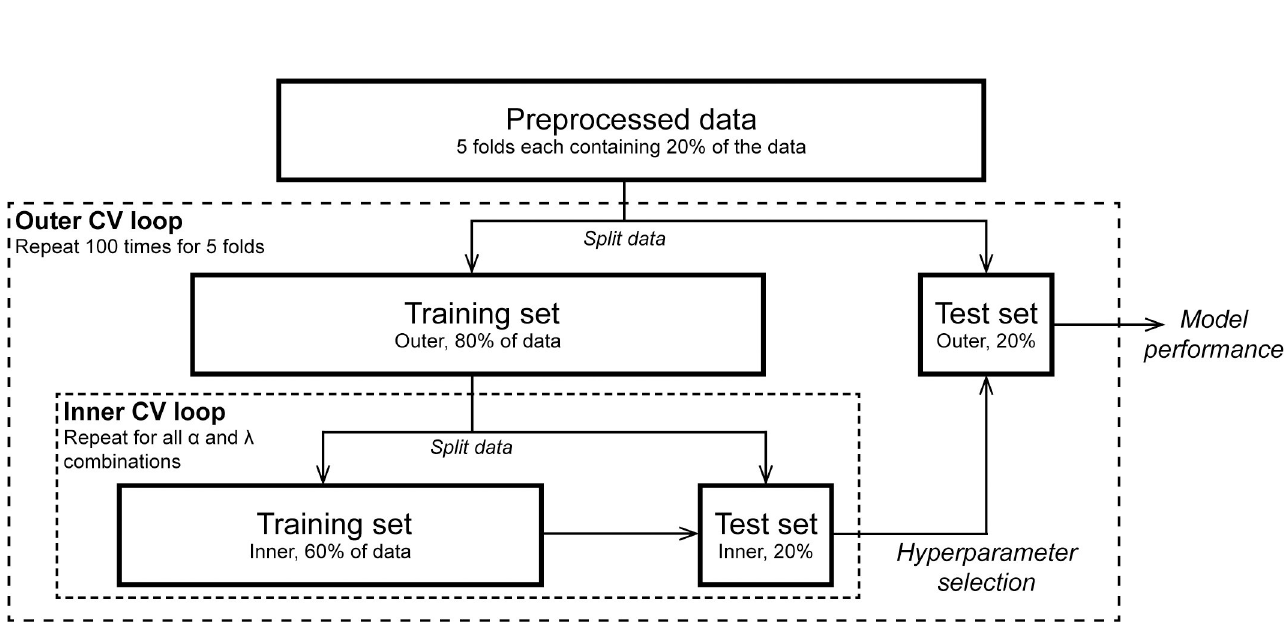
Fig 2. Schematic representation of stratified nested cross-validation for elastic net regression model optimization and performance [21]. Abbreviations: CV: cross-validation.